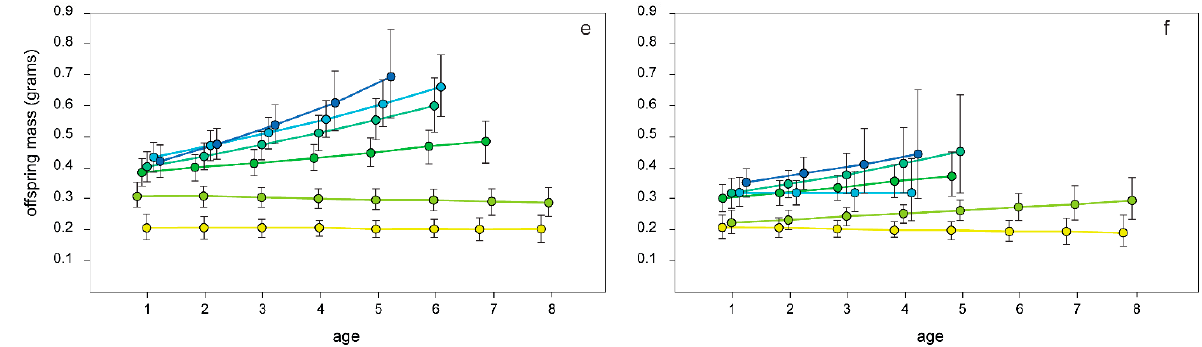
Figure 4. ( a ) Mean initial brood size (error bars are 95% confidence intervals on all panels) of N. marginatus across six carcass sizes (yellow circles represent the smallest carcass sizes grading to blue for the largest carcass sizes; same across all panels) by reproductive bout as age. ( b ) Mean initial brood size of N. guttula across six carcass sizes by reproductive bout as age. ( c ) Mean final brood size of N. marginatus across six carcass sizes by reproductive bout as age. ( d ) Mean final brood size of N. guttula across six carcass sizes by reproductive bout as age. ( e ) Mean offspring mass of N. marginatus across six carcass sizes by reproductive bout as age. ( f ) Mean offspring mass of N. guttula across six carcass sizes by reproductive bout as age.